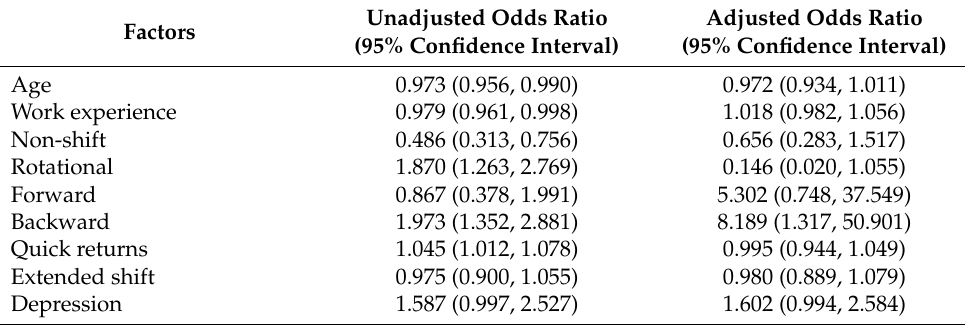
Table 4. Factors associated with poor sleep quality in nurses by adding various shift patterns. Unadjusted Odds Ratio Factors (95% Confidence